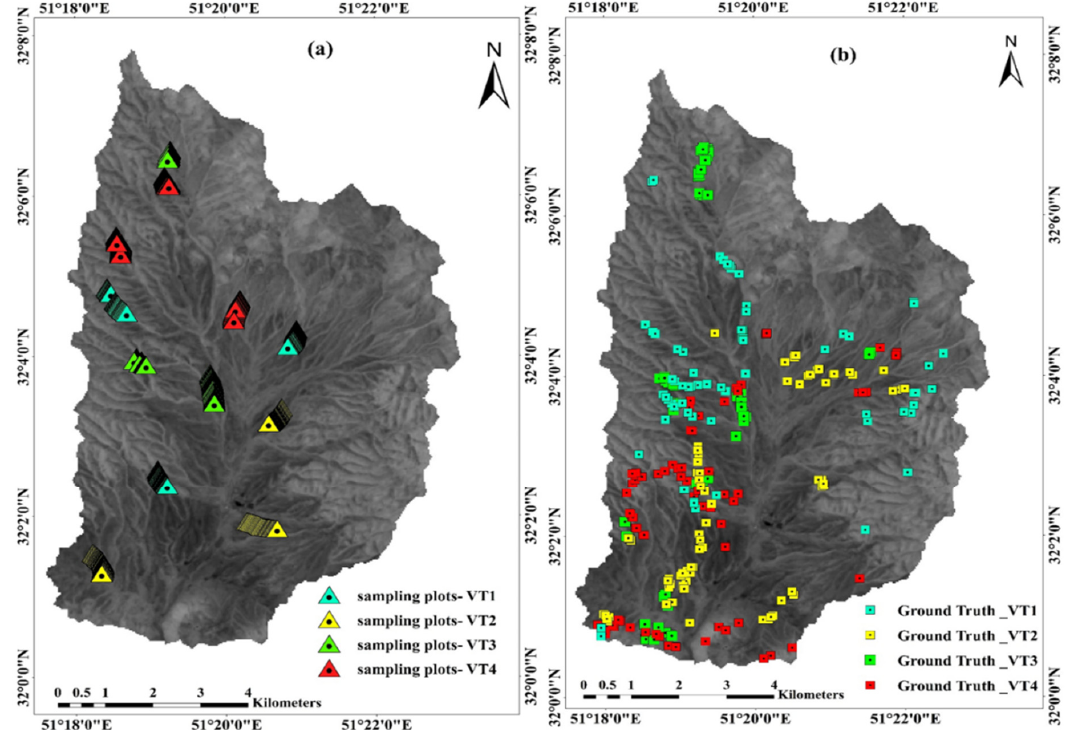
Figure 3. Study area boundary. ( a )—Distribution of the field canopy cover sampling plots. ( b )—The set of sampling points of VTs recorded in the field, which later divided into two groups of training and verification samples. Table 1. The identified VTs and their vegetational characteristics in the study area.